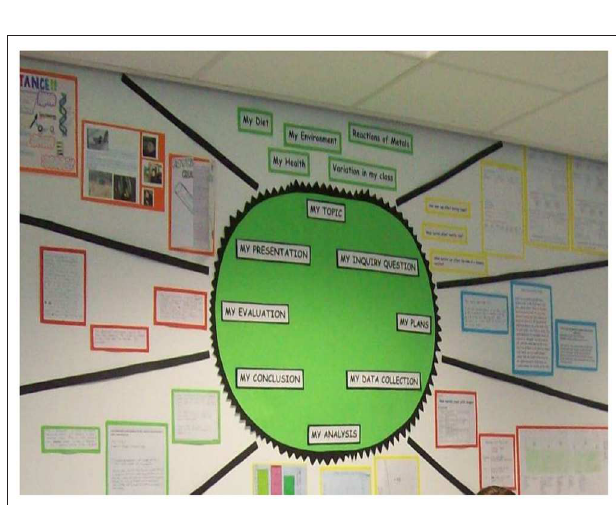
FIGURE 8 | Personal Inquiry poster created by the teacher in Nottingham (2010). It lived long after the PI project had finished (it is reproduced from Sharples et al., 2015, p.